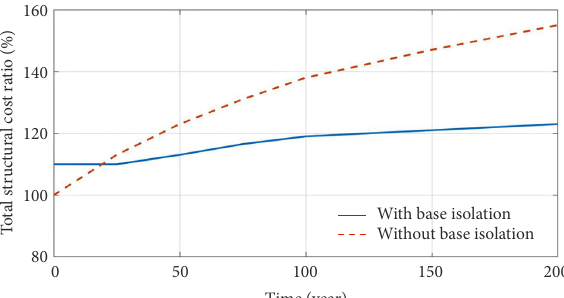
Fig. 5. Expected values of total structural cost with 10% of exceedance probability in the lifetime of the building (Luis, Satio